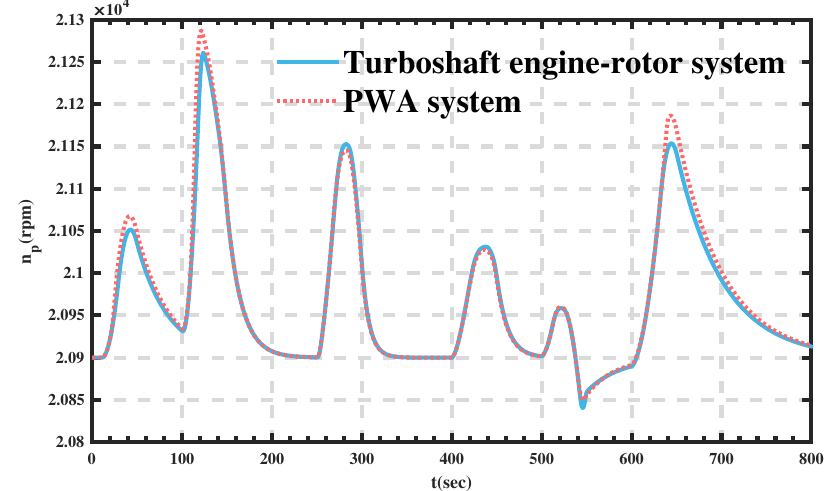
Figure 11. Speed response curves of power